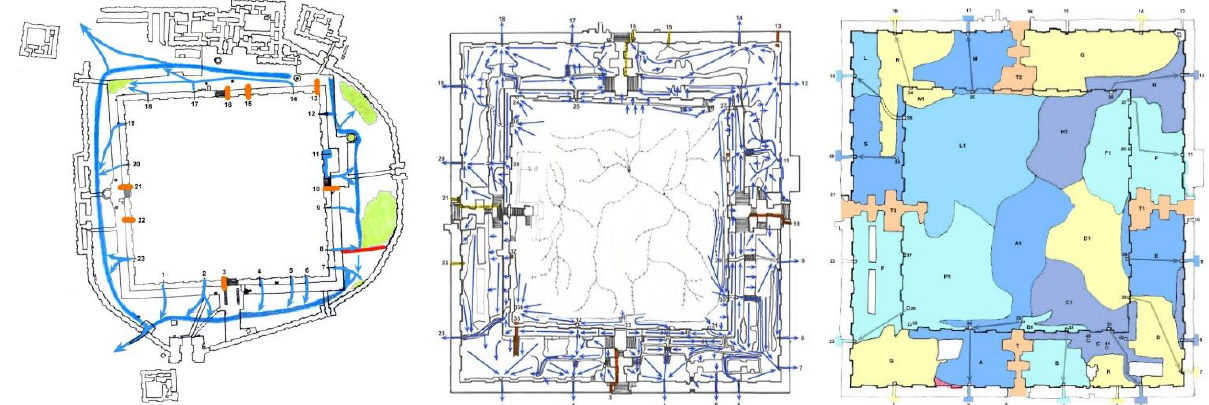
Figure 5. The maps of different basins of the upper part of the ziggurat and their connection to the gutters (Archive of Tchogha Zanbil